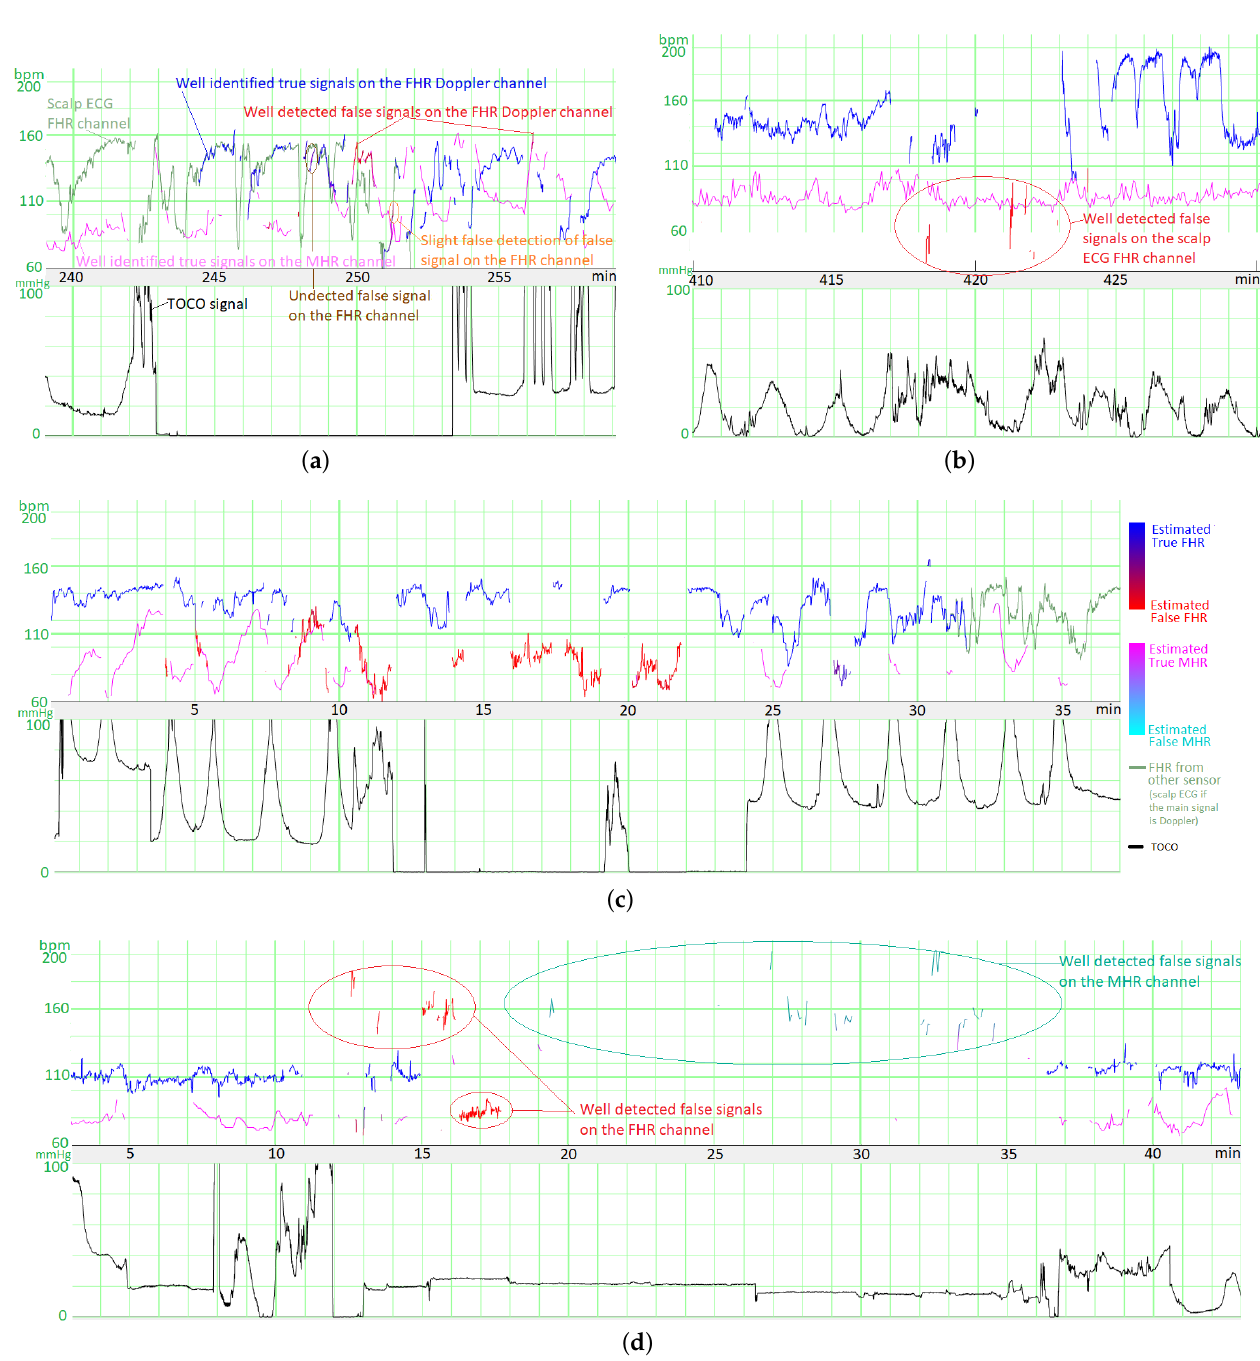
Figure 6. Examples of results for the three models (FSMHR, FSDop and FSScalp). ( a ) Results for FSScalp with a recording from the first stage of delivery. ( b ) Results for FSScalp with a recording from the first stage of delivery. ( c ) Results for FSDop and FSMHR with a recording from the first stage of delivery. ( d ) Results for FSDop and FSMHR with a recording from the first stage of delivery, during the administration of an epidural. The likelihood of an FS estimated by each model is represented as a color gradient. On examples ( a , c , d ), the blue/red signal corresponds to the Doppler channel and the green signal corresponds to the scalp ECG channel. On example ( b ), the blue/red signal is the scalp ECG signal. On all recordings, the time lag in the MHR had been corrected (as described in Section